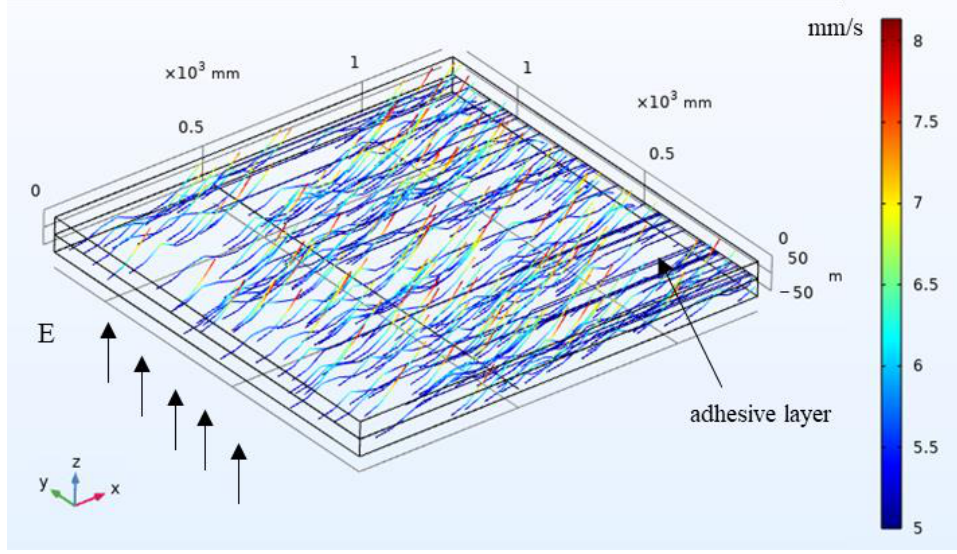
Figure 7. Particle motion of the mechanical model.